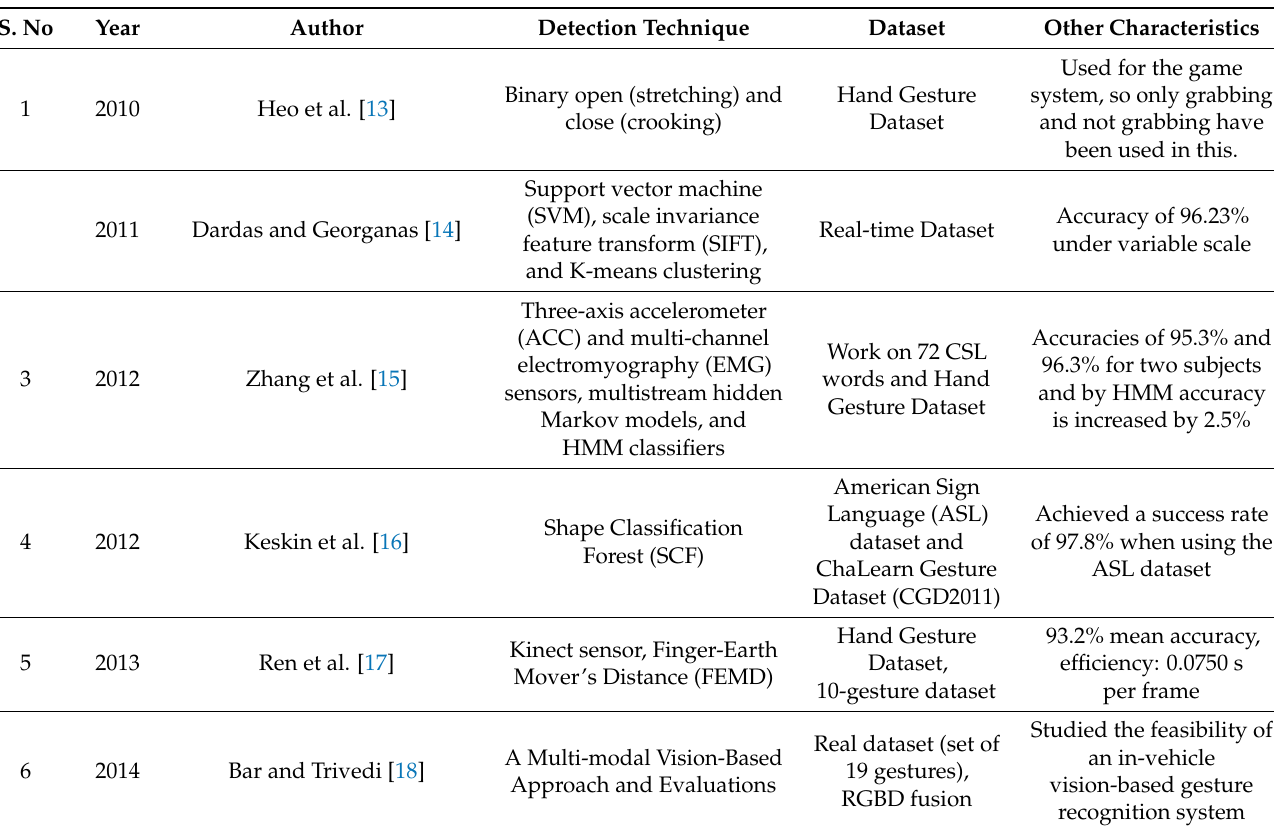
Table 1. Chronological summary of various techniques in the